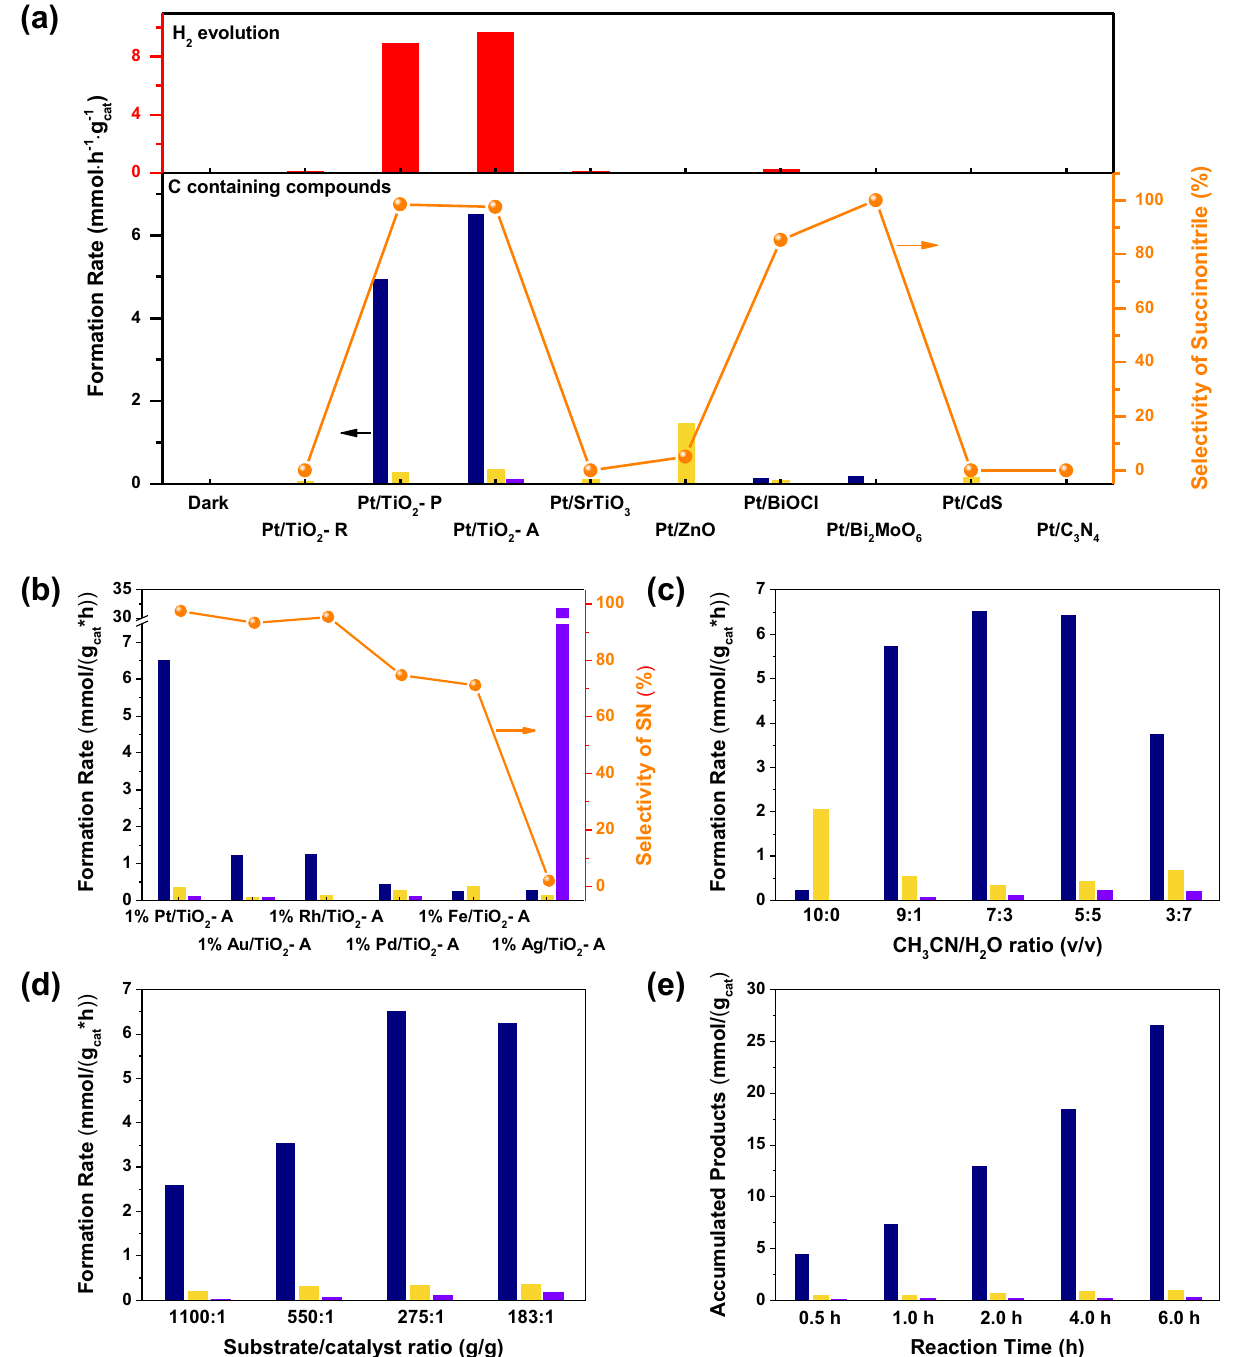
Fig. 3 | Catalytic performances evaluations of the photocatalytic dehy- drogenative coupling reaction over Pt/TiO 2 -A catalyst. a Succinonitrile forma- tion rates over various semiconductor supported Pt photocatalysts; ( b ) transition metal cocatalyst effect on the succinonitrile formation rate and selectivity;